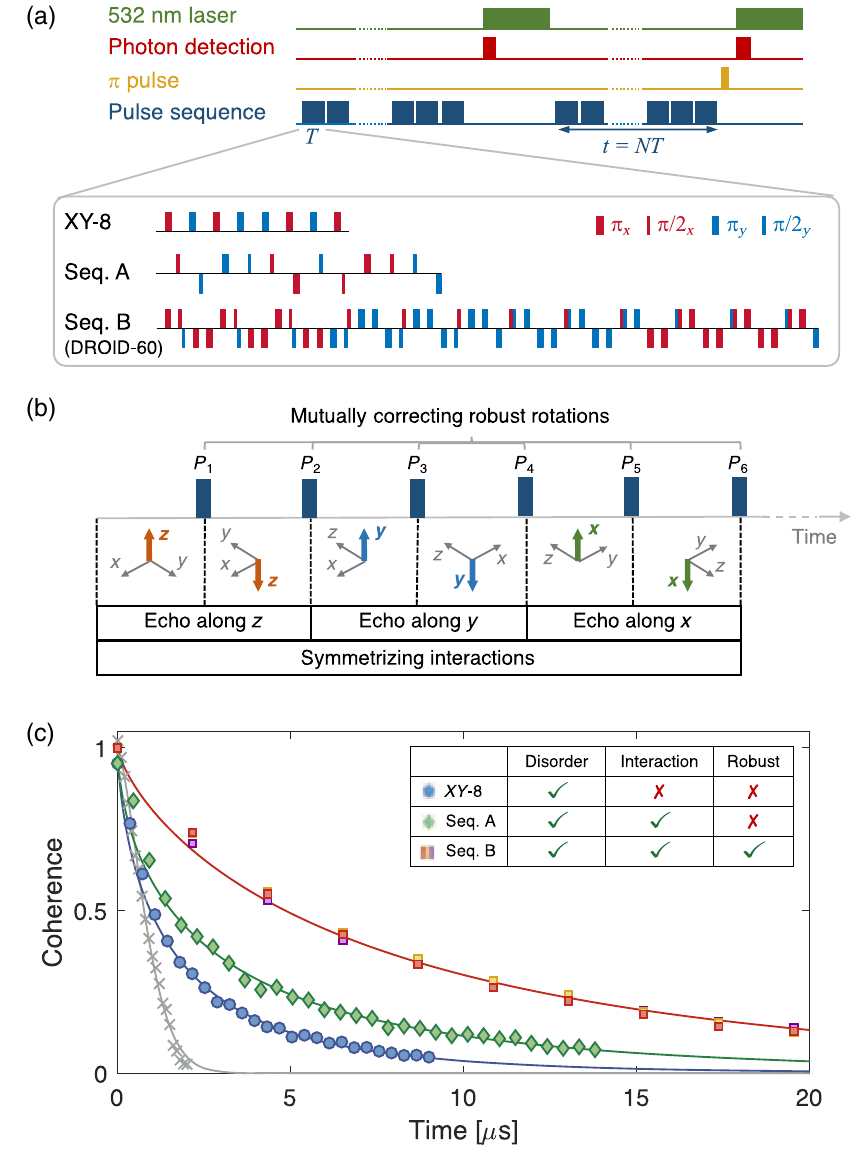
FIG. 2. Robust dynamical decoupling. (a) Measurement protocol. NV centers are initialized using pulsed laser excitation at 532 nm (green trace) and read out through emitted photons detected by a single photon counting module (red trace). We perform N repetitions of a sensing sequence unit of length T (blue trace) and repeat the same measurement with an additional π pulse (yellow trace) acting on the NV centers for differential readout of the spin state [17]. The box illustrates the details of different pulse sequences, XY-8, Seq. A, and Seq. B (DROID-60), composed of π = 2 and π rotations along ˆ x and ˆ y axes. Bars above (below) the line indicate driving along positive (negative) axis directions. (b) Key concepts for sequence design. The sequence is described by pulses P i and the time-dependent frame transformation of the system between the pulses. We highlight the orientation of each rotated frame by the axis that points along the ˆ z axis of the fixed external reference frame. Decoupling sequences are designed by imposing average Hamiltonian conditions on the evolution of the highlighted axis. For example, the effects of disorder can be canceled by implementing an echolike evolution, þ ˆ μ → − ˆ μ , where μ ¼ x , y , z (top row), and interactions are symmetrized by equal evolution in each of the ˆ x , ˆ y , and ˆ z axes in the transformed frames (bottom row). Additionally, the pulse sequence is designed to mutually correct rotation angle errors and finite pulse duration effects [17]. (c) Experimental performance of different sequences with their respective decoupling features (inset). We fit the decoherence profile with a stretched exponential e − ð t=T 2 Þ α (solid curves) to extract the coherence time T 2 for each sequence [17]. A simple spin echo (gray crosses), XY-8 (blue circles), and Seq. A (green diamonds) show T 2 ¼ 0 . 98 ð 2 Þ , 1.6(1), and 2 . 8 ð 1 Þ μ s with α ¼ 1 . 5 ð 1 Þ , 0.66(2), and 0.61(3), respectively. DROID-60 (squares), designed to correct for all leading-order effects of interactions, disorder, and control imperfections, gives T 2 ¼ 7 . 9 ð 2 Þ μ s with α ¼ 0 . 75 ð 2 Þ . We confirm that its coherence time is independent of the initial state prepared along ˆ x , ˆ y , and ˆ z axes, as shown in red, yellow, and purple, respectively. All sequences have pulse spacing τ ¼ 25 ns and π -pulse width τ ¼ 20 π